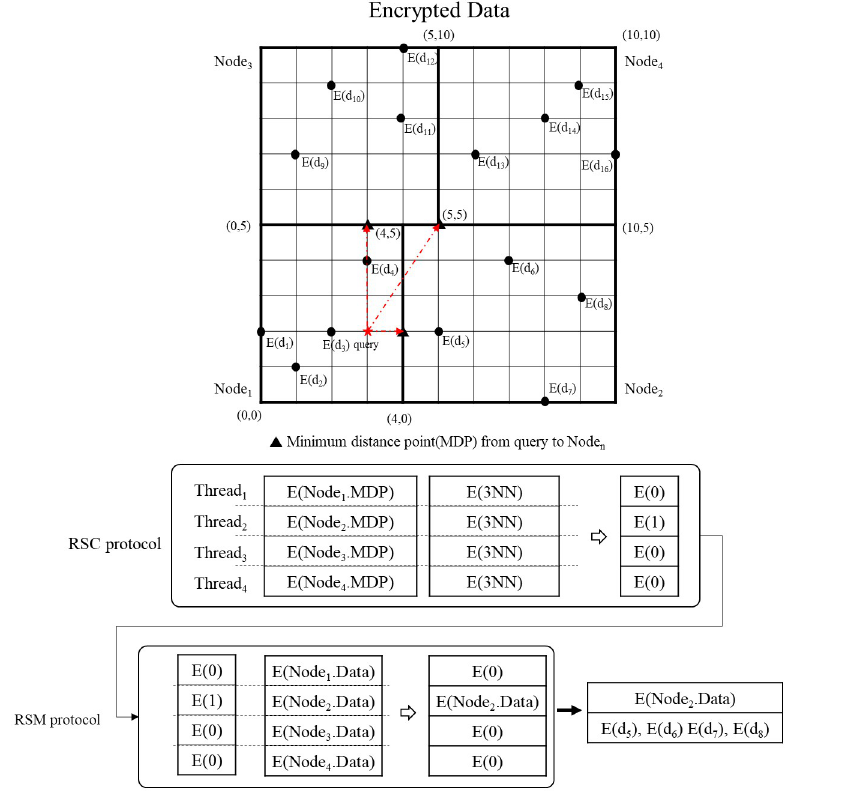
Fig 7. Example of index search in kNN verification